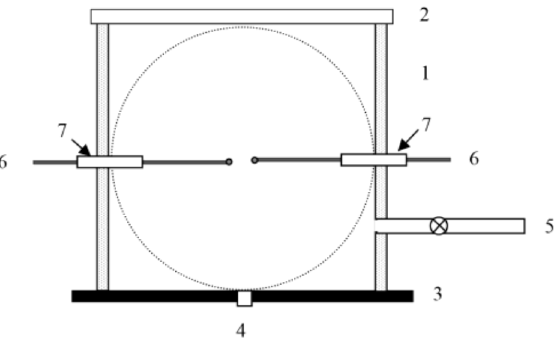
Figure 1. explosion vessel: 1—vessel body; 2—transparent top cover; 3—bottom cover; 4—pressure transducer; 5—feeding/evacuation pipe with tap; 6—high voltage electrodes; 7—electric insulation. A typical diagram p ( t ) recorded during the explosion of a 9% methane–air mixture at the initial temperature of T 0 = 298 K and initial pressure P 0 = 1 bar (100 kPa) is shown in Figure 2 together with its derivative. The derivation of the p (t) curve was performed ter a prior smoothing using the Savitzky–Golay method. This involves the analysis of 500–700 points in the range 0 ≤ t ≤ ɵ max . In all cases, a smoothing level of 5% was used, as a and signal distortion.